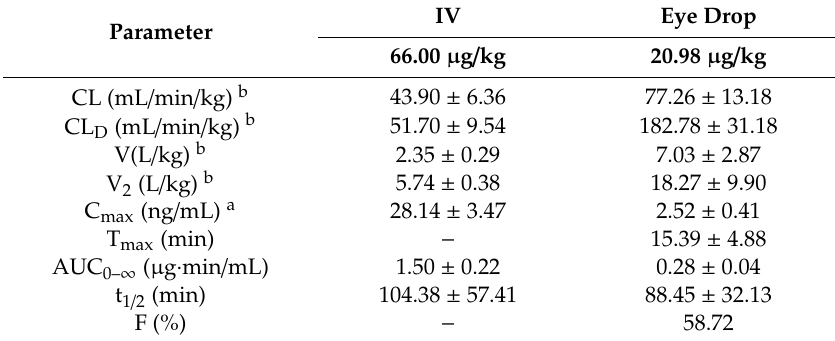
Figure 6. Plasma concentration-time profiles of CK41016 described by the two-compartment model after IV ( A ) or eye drop administration ( B ) in rabbits. Each value represents the mean ± SD ( n = 5). Table 3. PK parameters of CK41016 following IV or eye drop administration in rabbits (Mean ± SE, n =